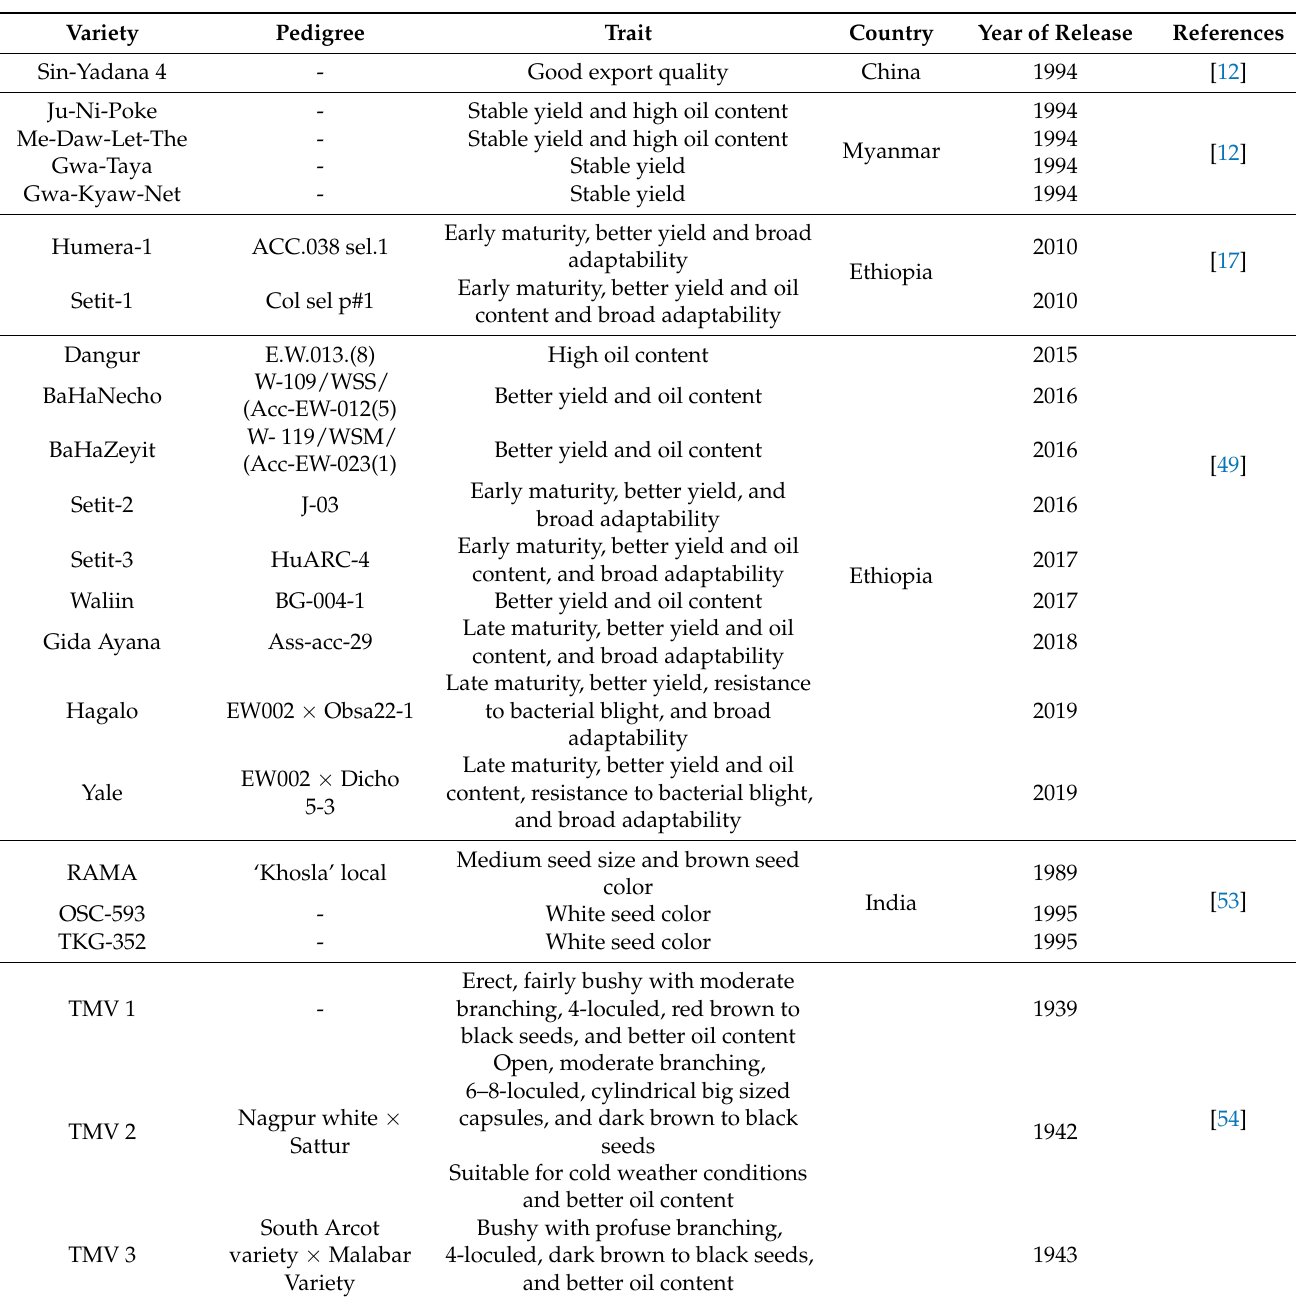
Table 3. Modern sesame varieties reported globally with desirable agronomic and seed oil